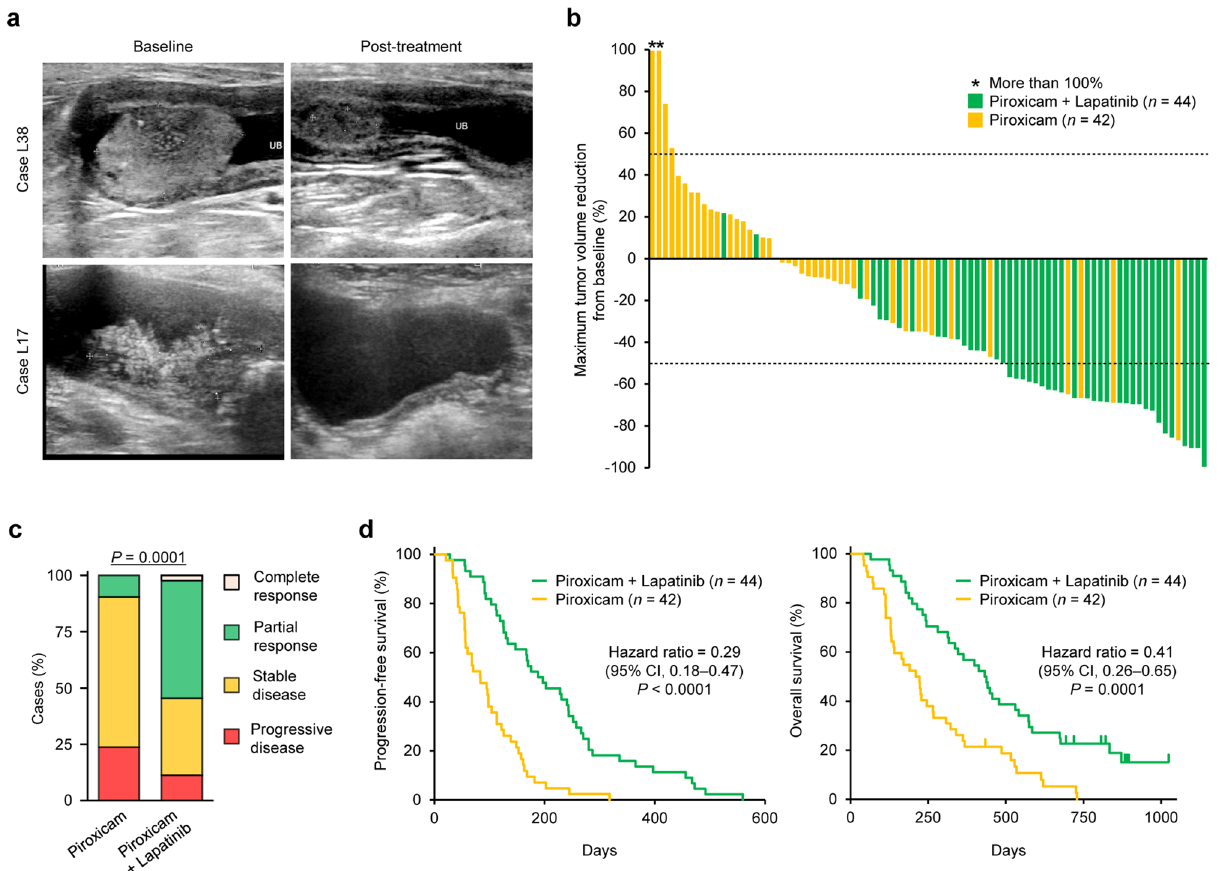
Figure 1. Lapatinib induces clinical responses and improves the survival in dogs with urothelial carcinoma. ( a ) Representative ultrasonographic images of bladder masses in dogs treated with lapatinib and piroxicam. In case L38, the bladder mass shrunk 4 weeks after treatment compared to baseline. In case L17, the bladder mass observed before treatment was completely absent 12 weeks after treatment. ( b ) Waterfall plot showing the maximum percentage of tumor burden reduction from baseline in dogs treated with lapatinib and piroxicam ( n = 44, green) or in dogs treated with piroxicam alone ( n = 42, yellow). Dashed lines indicate ± 50%. Asterisk indicates a value > 100%. ( c ) Clinical responses in dogs treated with lapatinib and piroxicam ( n = 44) or piroxicam alone ( n = 42). Cochran–Armitage test. ( d ) Progression-free survival (left) and overall survival (right) in dogs treated with lapatinib and piroxicam ( n = 44, green) or in dogs treated with piroxicam alone ( n = 42, yellow). Log-rank test and Cox proportional hazard